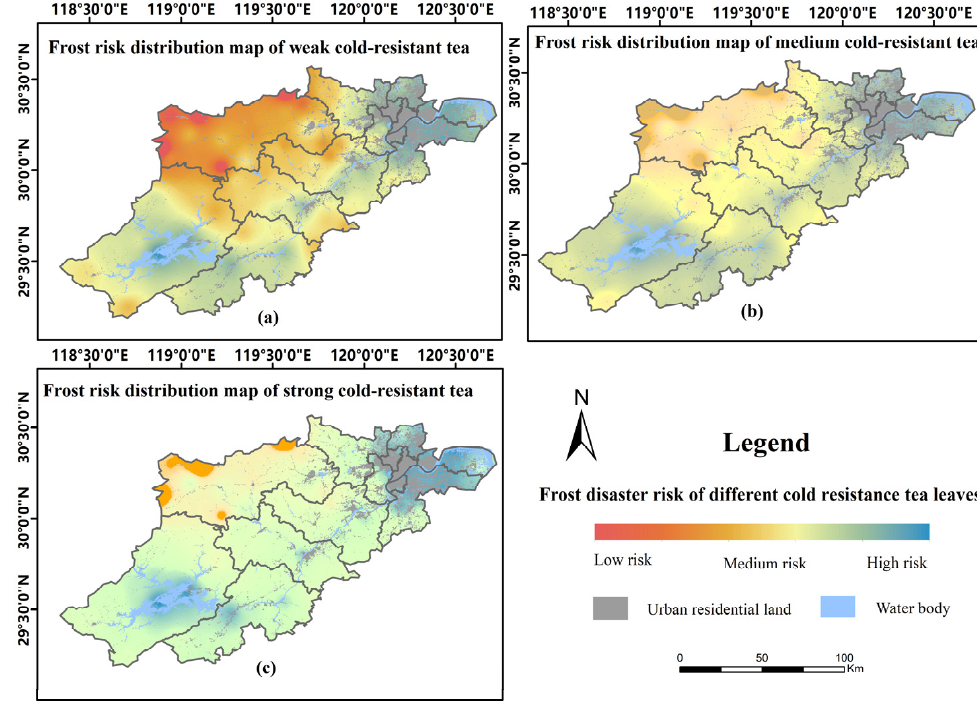
Figure 2. Spatial distribution of model indicators: ( a ) Spatial distribution map of early spring frost- induced disaster factors for weak cold-resistant tea; ( b ) Spatial distribution map of early-spring frost-induced disaster factors for moderate cold-resistant tea; ( c ) Spatial distribution map of early spring frost-induced disaster factors for strong cold-resistant tea.